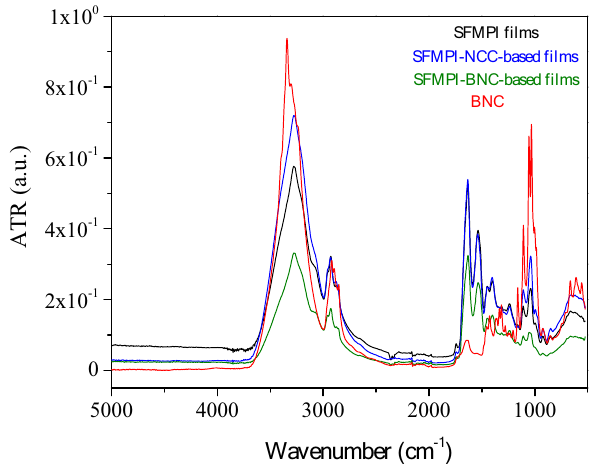
Figure 1. FTIR spectra of BNC derived after the acid hydrolysis of bacteria cellulose, SFMPI biofilms, SFMPI- NCC- and SFMPI-BNC-based